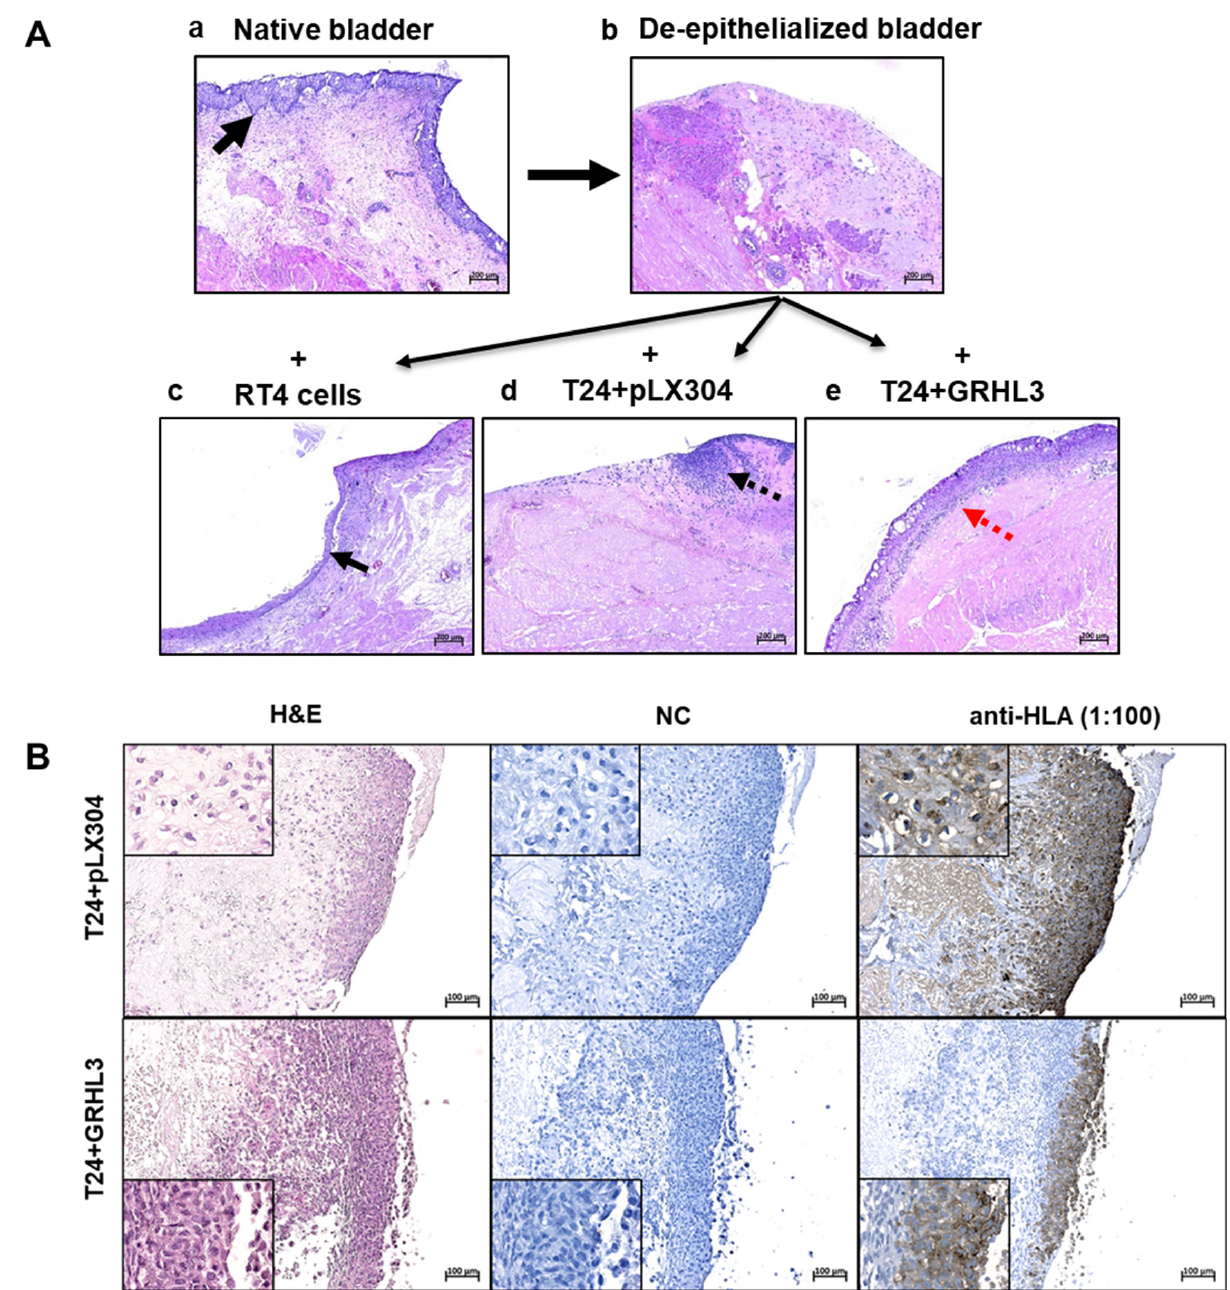
Figure 6. ( A , a – e ) Representative formalin-fixed, paraffin-embedded (FFPE) hematoxylin and eosin (H&E) tissue sections of porcine bladders after 10 days in organ culture. ( a ) Native, untreated porcine bladder with intact morphology maintaining urothelium (black arrow), stroma and muscle tissue. ( b ) The de-epithelialized porcine bladder with stromal and muscle tissue, without urothelial re-growth, used as negative control. ( c – e ) Cell lines were seeded onto de- epithelialized bladder tissue and grown in organ culture. While non-invasive RT4 cells formed a stratified multi-layer on top of the basal membrane ( c , black arrow), T24 cells with empty vector controls (T24 + pLX304) showed diffuse invasion into the stromal compartment ( d , black dotted arrow). In contrast, T24 cells overexpressing GRHL3 (T24 + GRHL3) did not invade but instead formed a superficial multi-layer on the pig stroma, similar to non-invasive RT4 cells ( e ). Four biological replicates were performed for each experiment. Scale bar, 200 µ m. ( B ) Anti-human leukocyte antigen (Anti-HLA) staining confirms the invasive capacity of T24 + pLX304 cells into the pig bladder stroma and muscle tissue as well as the reduced invasion ability upon overexpression of T24 + GRHL3. (H&E, hematoxylin and eosin; NC, negative